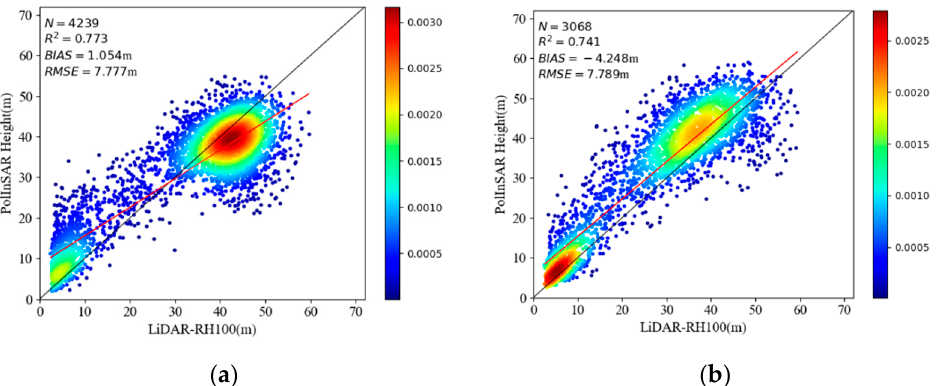
Figure 8. Plots showing forest height validation results of RVoG model inversion in the ( a ) Lope and ( b ) Pongara test areas.